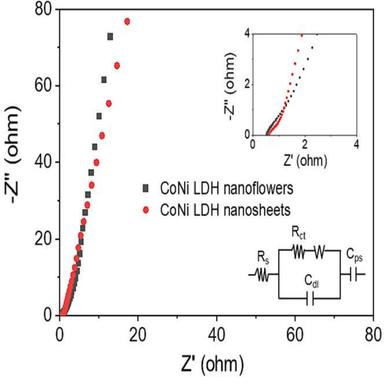
The Nyquist plots of CoNi LDH NFs and CoNi LDH NSs, and the enlarged Nyquist plots and corresponding equivalent circuit diagram were presented in the inset.